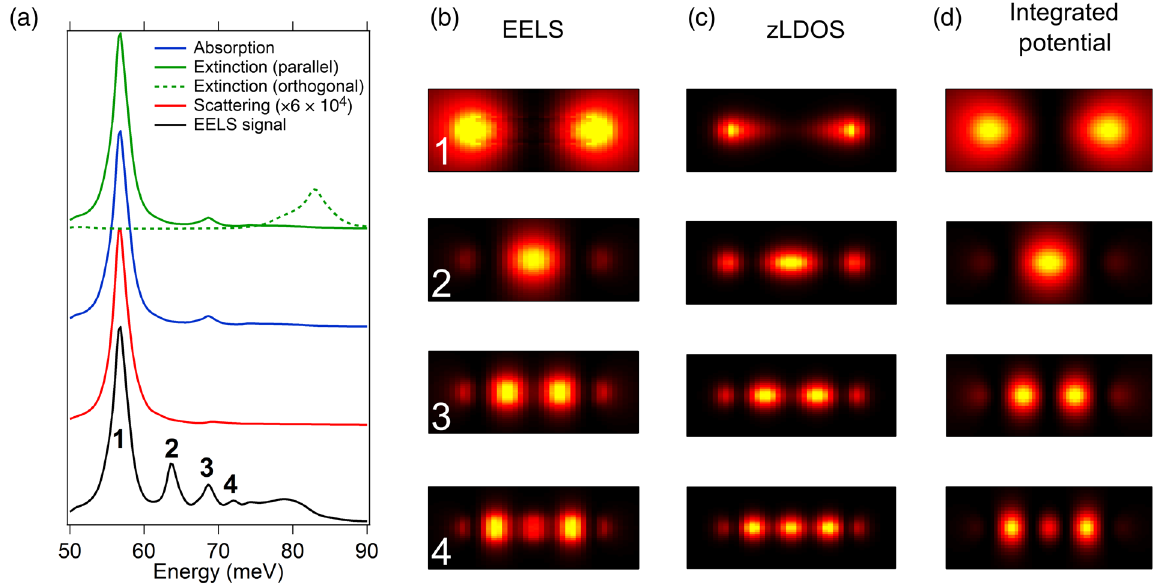
FIG. 2. Optical cross sections, EELS, EMLDOS, and eigenpotentials for the cSPh in a nanorod of MgO. (a) Simulated optical cross sections for an incoming beam propagating perpendicular to the nanorod axis, and EELS spectrum for an electron beam located 10 nm away from one tip of the nanorod. All spectra have been shifted for clarity. Optical cross section scales are the same for extinction and absorption, and multiplied by 6 × 10 4 for scattering. The polarization of the electrical field is parallel to the nanorod axis, except for the dotted curve. The nanorod is 200 nm in length and 30 nm in diameter. (b) EELS maps for the four first modes of the nanorod. (c) Corresponding zEMLDOS maps taken at z ¼ 10 nm from the surface of the rod. (d) Corresponding z -integrated